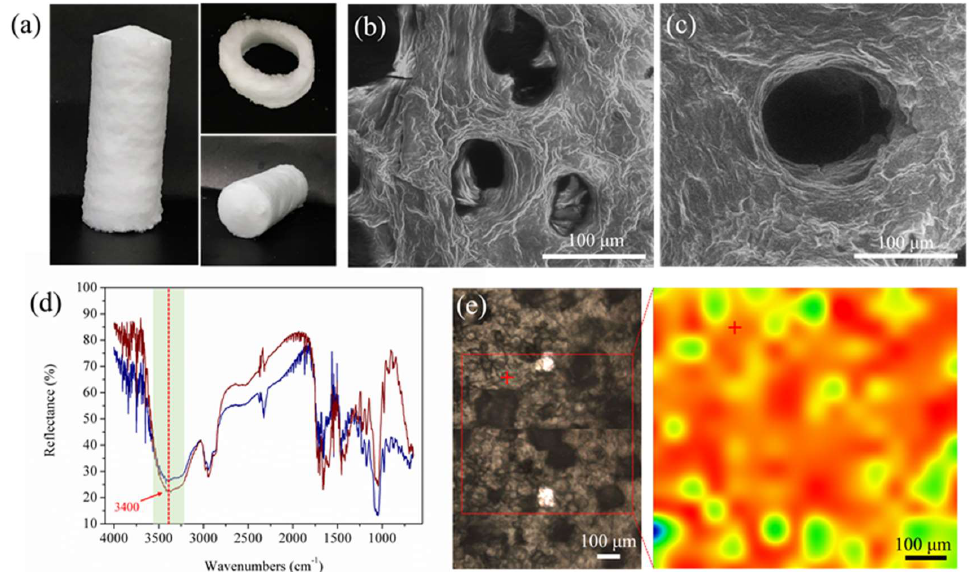
Figure 5. ( a ) Photographs of initial aqueous foam stabilized by 8 wt% GA nanofibrils, obtained by cooling in an ice bath (2 °C), made with cylindrical and annular molds. ( b , c ) Environmental SEM images of this initial wet foam. ( d ) FTIR spectra collected from this foam in D 2 O and ( e ) FTIR image (right) and the corresponding bright field image (left) of this foam, obtained by plotting the reflectance at 3400 cm −1 (associated with hydrogen bonding); colors qualitatively indicate the strength gradients of hydrogen bonds from low (blue) to high (red), showing the strong interfibrillar hydrogen bonding in the continuous phase as well as around the bubble surfaces. Images were reproduced with permission from [35].